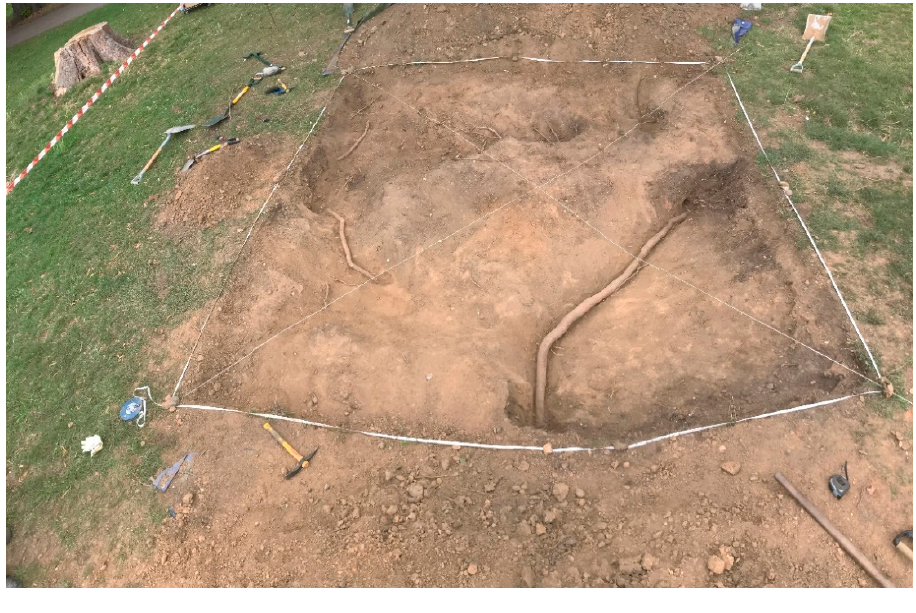
Figure 17. The excavated site. Remote Sens. 2020 , 12 , x FOR PEER REVIEW